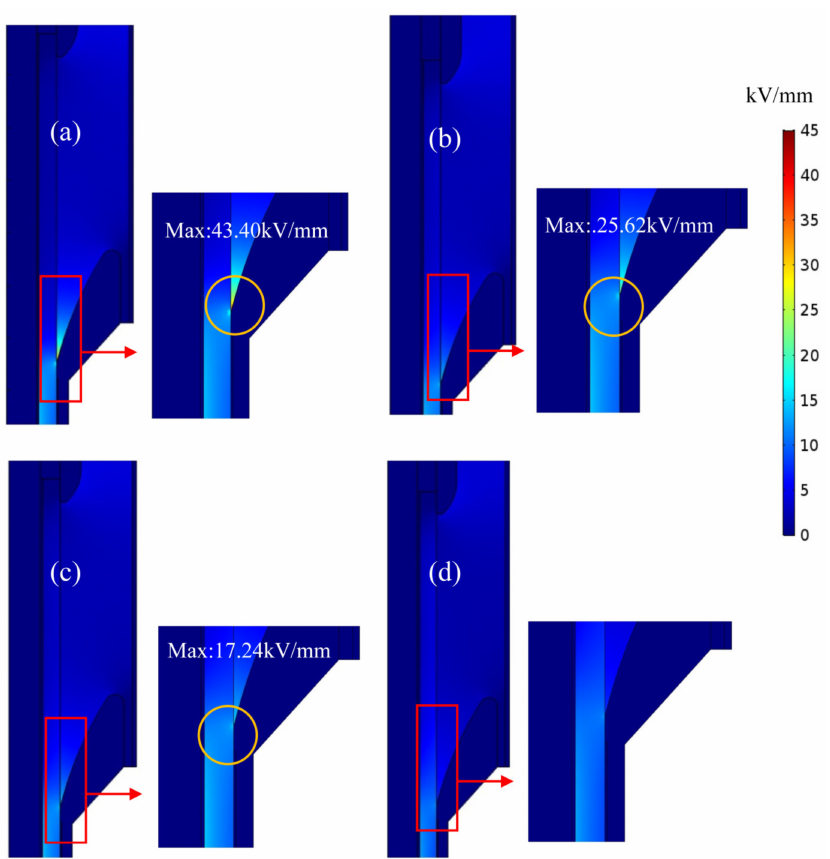
Figure 9. Steady-state electric field distributions in a cable joint with reinforce insulation of: ( a ) pure LSR and SiC/LSR nanocomposites of ( b ) 5 wt%; ( c ) 10 wt%; and ( d ) 20 wt% SiC